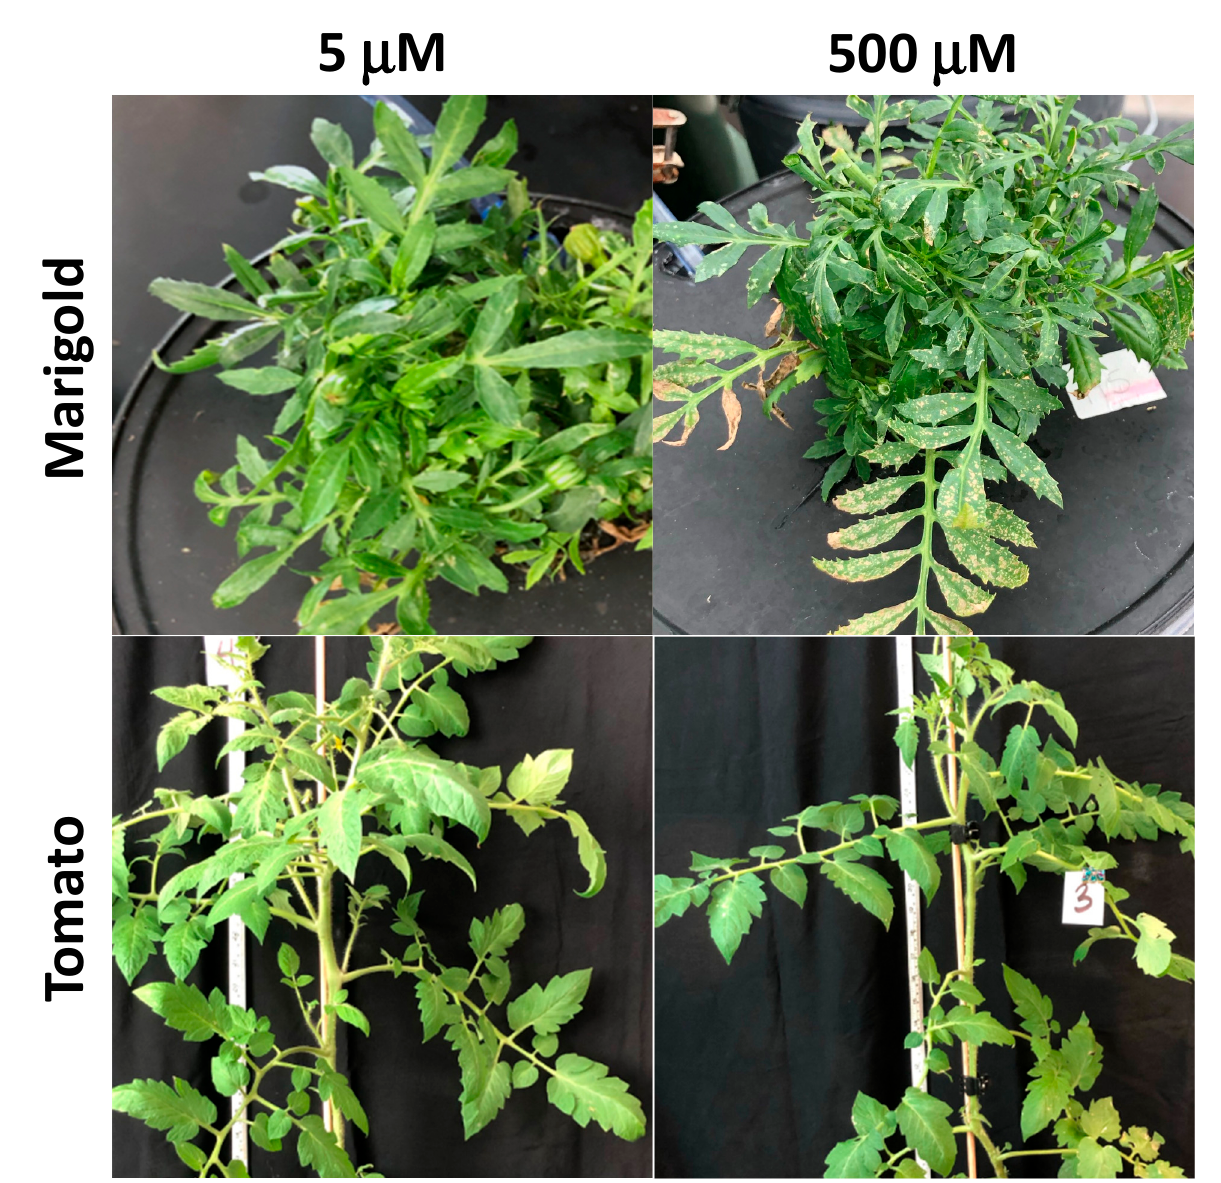
Figure 1. Effects of variation in Fe availability in marigold and tomato on leaf appearance. Note leaf damage from high Fe in marigold, visible as brown spots, while no damage is apparent in tomato. In marigold, both total plant mass and root-to-shoot mass ratio decreased as Fe availability increased from 5 to 50 µ M and from 50 to 500 µ M Fe (note: although total mass did not differ among treatments with ANOVA, a t -test indicated that 5 and 500 µ M Fe were different from each other at p = 0.04) (Figure 2). Shoot Fe concentration did not increase from 5 to 50 µ M Fe, but increased 2.4-fold from 50 to 500 µ M Fe. Root Fe concentration, meanwhile, increased 2.5-fold from 5 to 50 µ M Fe, but did not increase further from 50 to 500 µ M Fe (500 µ M was 1.8-fold higher than 5 µ M). Fe uptake per g root increased 2.6-fold from 5 to 50 µ M Fe, but did not increase further from 50 to 500 µ M Fe. In contrast, the concentration of total protein in roots was unaffected by Fe availability.